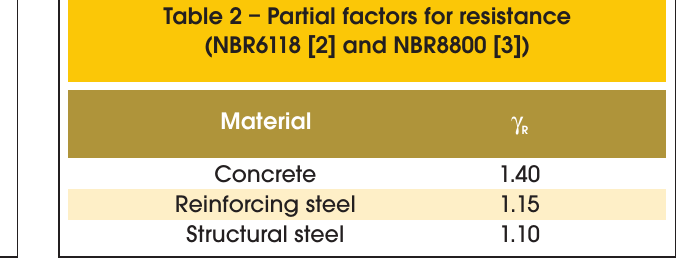
Table 2 – Partial factors for